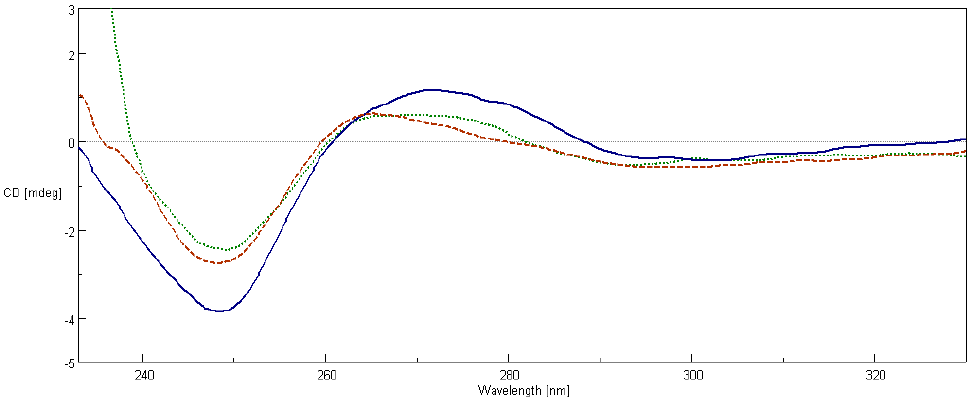
Figure 8. The CD spectra of pure ds-oligonucleotide 2.5 µM (solid), ds-oligonucleotide with 2a at a concentration of 2.5 µM added before hybridization (ON1—dots) and ds-oligonucleotide with 2a at a concentration of 2.5 µM added after hybridization (ON2—dashes).